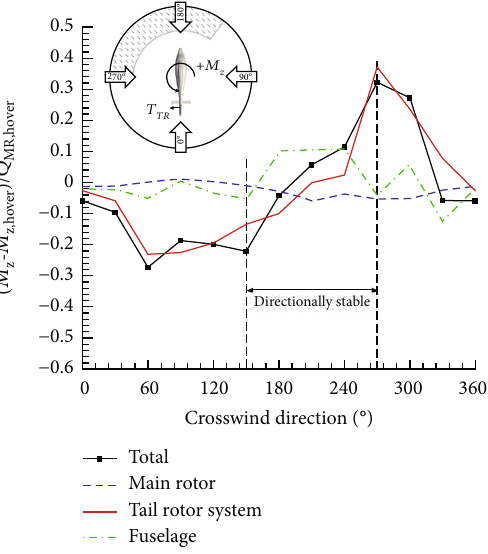
Figure 19: Yawing moment of each